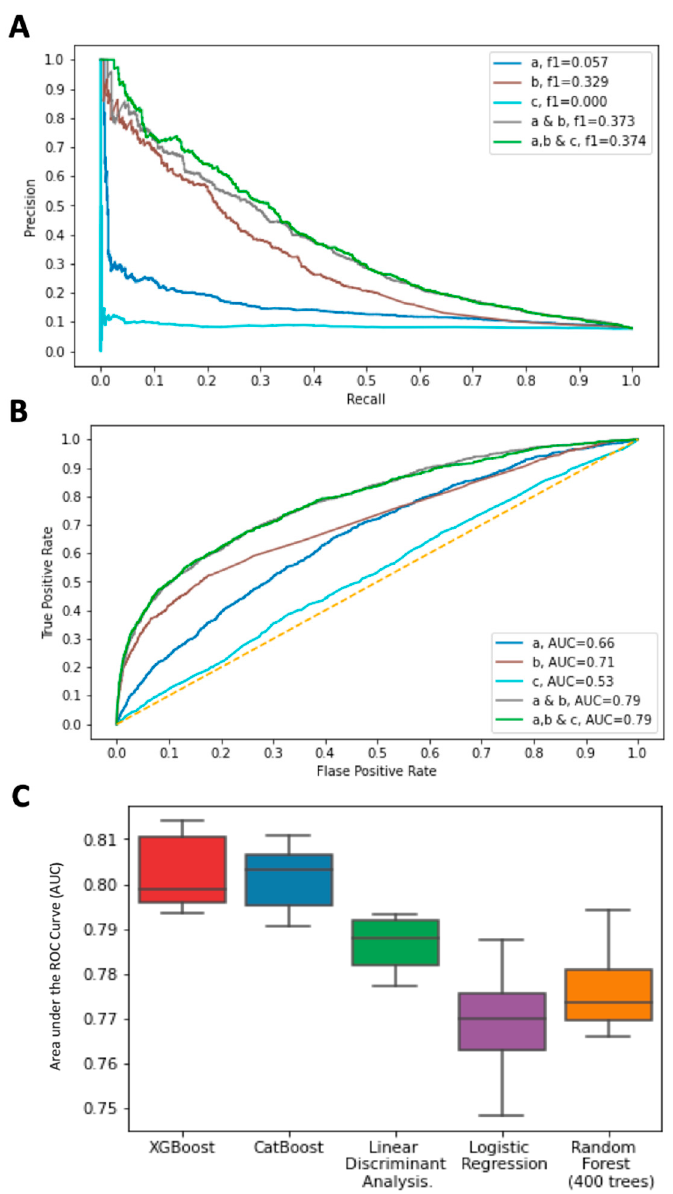
Figure 5. Performances of the prediction models for endometriosis. ( A ) Precision–recall curves for 5 CatBoost models. The models differ by training data with the UKB attributes and measurements (model a), the collection of the ICD-10 prior to endometriosis diagnosis age (model b), and the GWAS of endometriosis genetic variants (model c). A combination of training data of a and b and a combined model that includes a, b and c. ( B ) ROC curves for the same set of 5 models as in A. The diagonal line marks a random no-discrimination line (AUC = 0.5). ( C ) A comparison of the ROC-AUC of five different algorithms for the combined set of input features a, b, and c. XGBoost and CatBoost resulted in the highest performance according to ROC-AUCs.